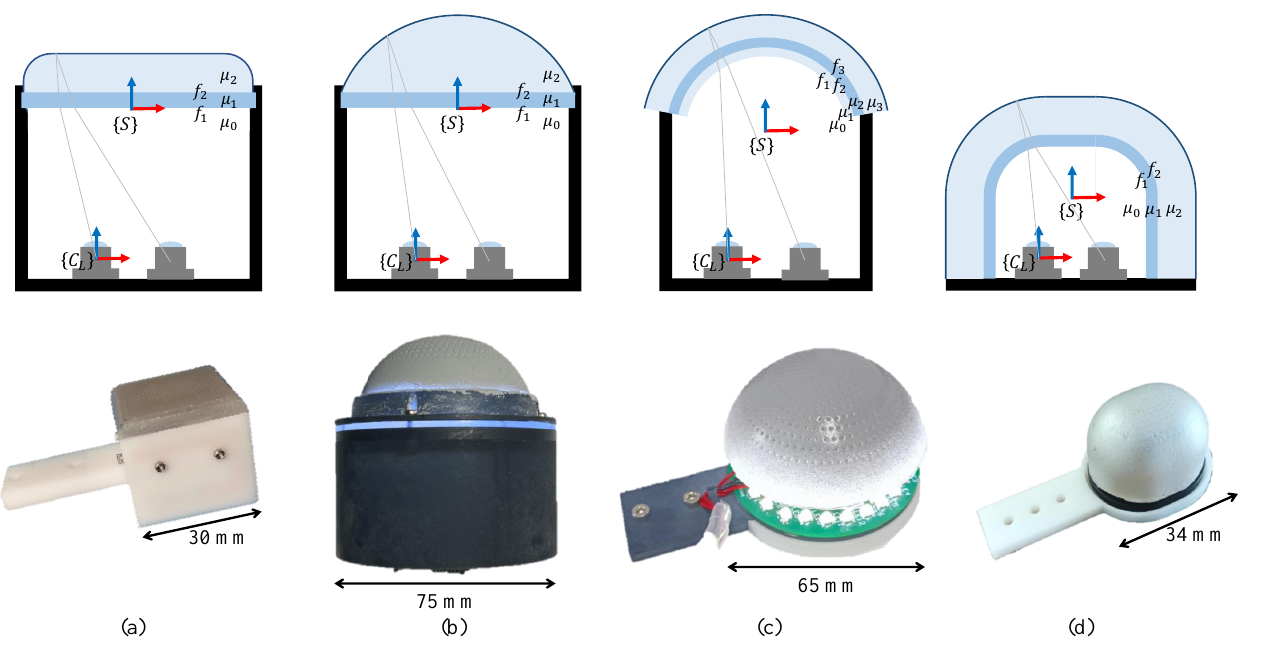
Figure 4. The GelStereo-type sensors. The first row shows a diagram of sensor imaging systems with multi-medium refraction. The second row shows pictures of real-world sensors. ( a ) The GelStereo Tip sensor. ( b ) The GelStereo Palm sensor with flat refracting surface (GelStereo Palm2.0). ( c ) The GelStereo Palm sensor with hemispherical refracting surface (GelStereo Palm1.0) [37]. © [2023] IEEE. Reprinted, with permission, from [37]. ( d ) The GelStereo BioTip